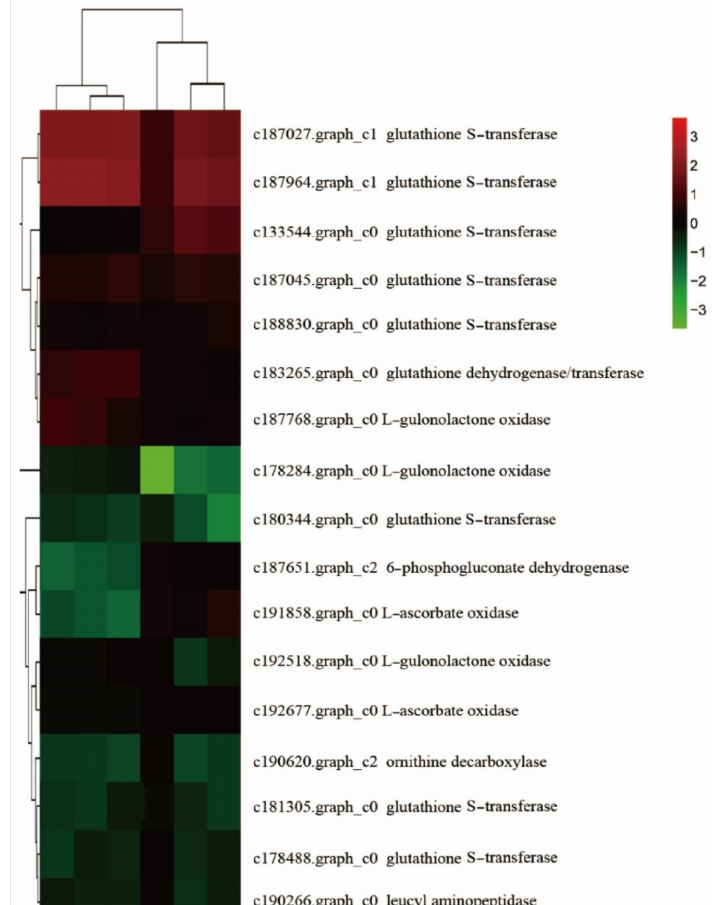
Figure 3. Cluster heat map of GSH-related differential genes between F and S cell lines of Korean pine. Note: F1, F2, and F3 are three biological replicates of the F cell line; S1, S2, and S3 are three biological replicates of the S cell line, The note of Figure 4 and Figure 8 are the same as Figure